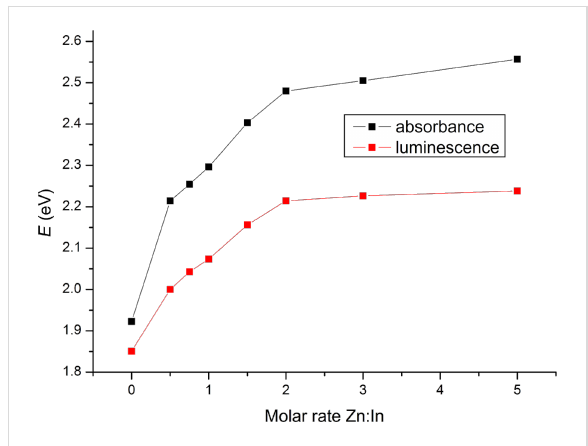
Figure 6: Dependence of UV–vis absorption spectra and PL peak pos- ition on M nom